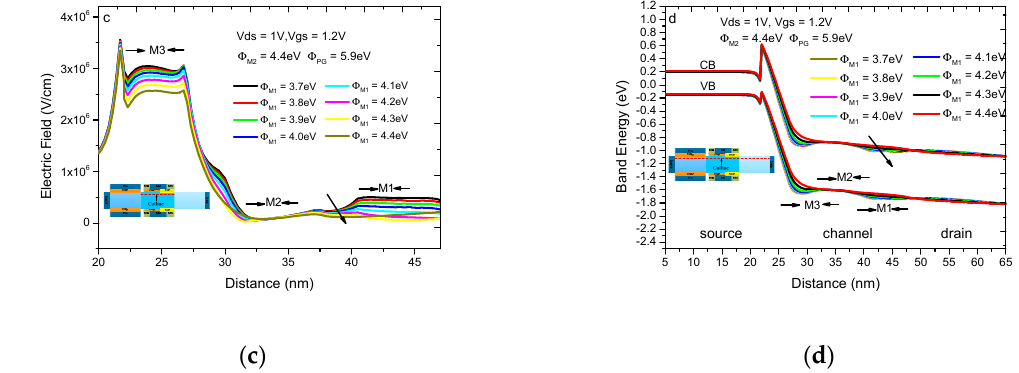
Figure 9. ( a ) Transfer characteristics of the DMGE-HJLTFET with different auxillary gate workfunction ( Φ M1 ); ( b ) the potential distribution with different Φ M1 ; ( c ) the distribution of electric field with different Φ M1 ; ( d ) the ON-state energy band diagram with different Φ M1 .